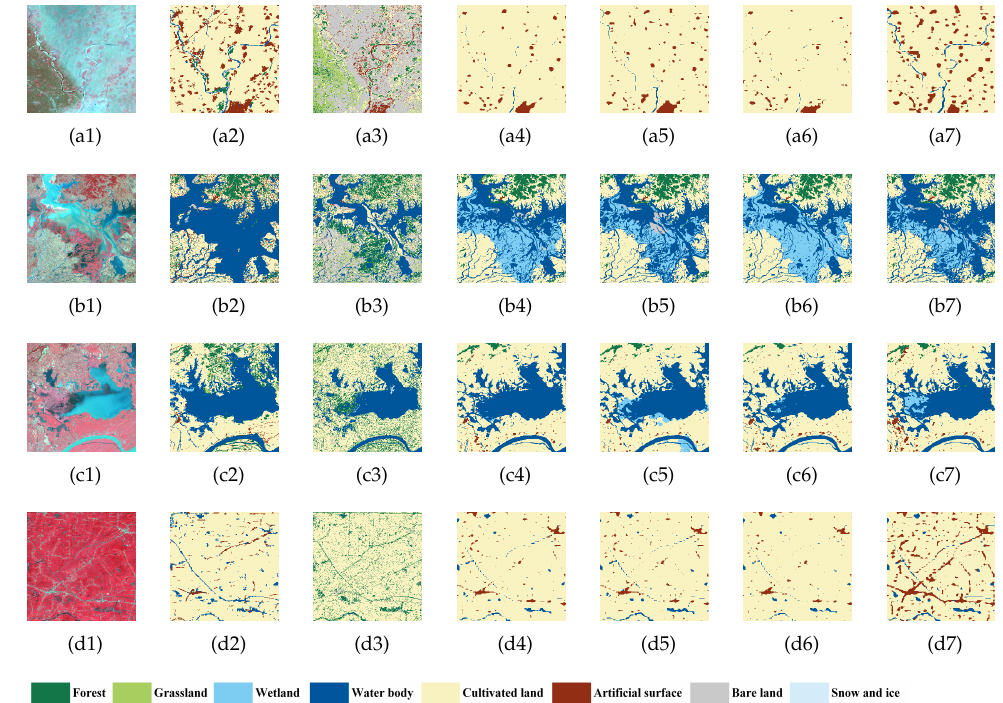
Figure 7. Detailed classification results for Hubei, where ( a1 – d1 ) are the original Landsat images, ( a2 – d2 ) are the reference, ( a3 – d3 ) are classification results for RF classifier, ( a4 – d4 ) are classification results of PSPNet-RL, ( a5 – d5 ) are classification results of PSPNet, ( a6 – d6 ) are classification results of PSPNet-TF, and ( a7 – d7 ) are classification results of MTNet. The results shown in ( a1 – b7 ) are for the year 2005; the results shown in ( c1 – d7 ) are for